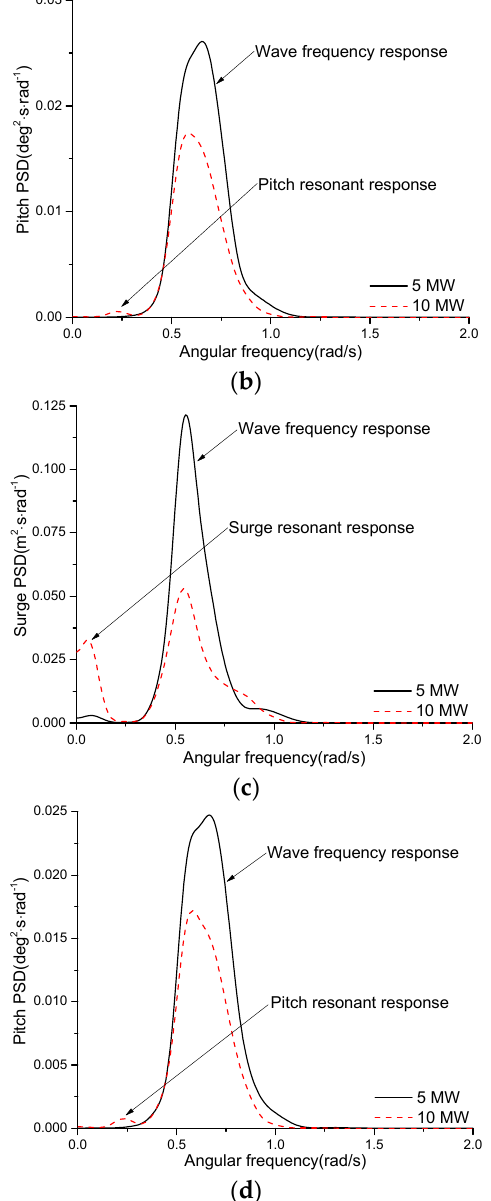
Figure 14. Comparison of power spectra of platform motion responses. ( a ) Power spectra of surge motion for the LC3 case; ( b ) power spectra of pitch motion for the LC3 case; ( c ) power spectra of surge motion for the over-rated wind speed (LC6) case; ( d ) power spectra of pitch motion for the LC6 case.